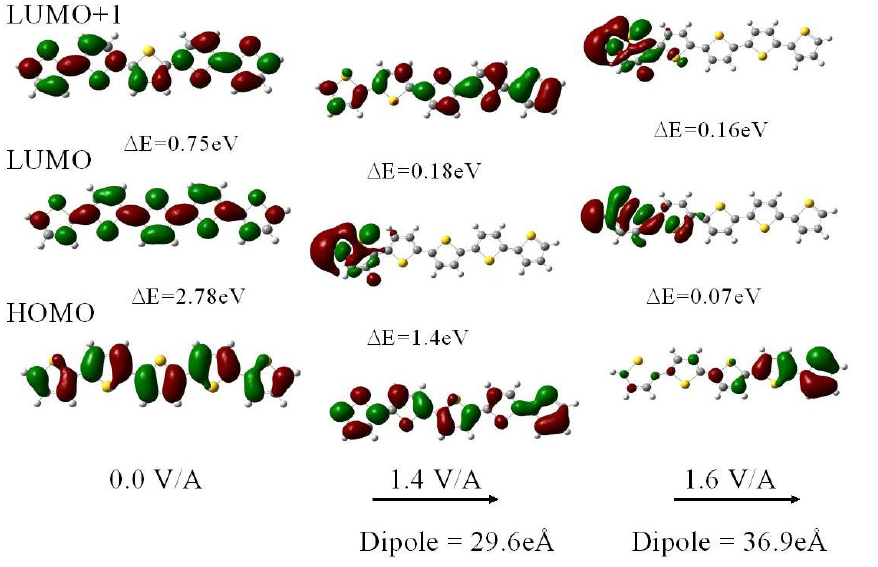
Figure 2. π orbital charge density for the HOMO and two lowest LUMOs of polythiophene in various fields. Also noted are the energy differences between them and the induced dipole